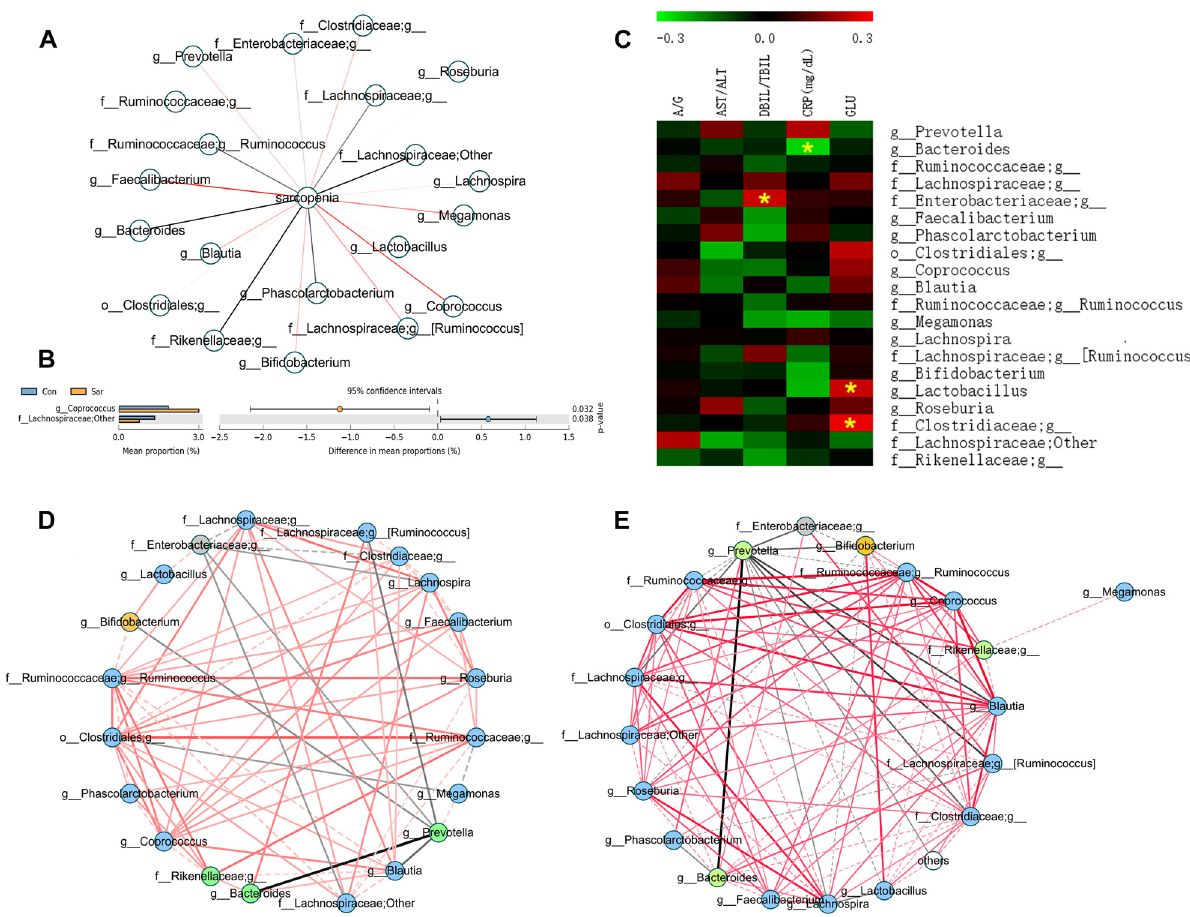
Figure 3: The interactions between the gut microbiota and sarcopenia (control group=0, sarcopenia group=1) (A). Signi fi cant differences in genera between the control group and the sarcopenia group (B). In Figure 3A, the red line indicates a positive correlation, the black line indicates a negative correlation, the solid line indicates the con fi dence level (double measurement) of a 0.01 signi fi cant correlation, and the broken line indicates the con fi dence level (double measurement) of a 0.05 signi fi cant correlation. The darker the color is, the greater the absolute value of the correlation coef fi cient. Heat map of Spearman interactions between blood indexes and the intestinal microbiome of sarcopenia patients. The color block marked with * indicates a signi fi cant correlation (C). Spearman interactions among gut microbiota constituents in the control group (D). Spearman interactions among gut microbiota constituents in the sarcopenia group